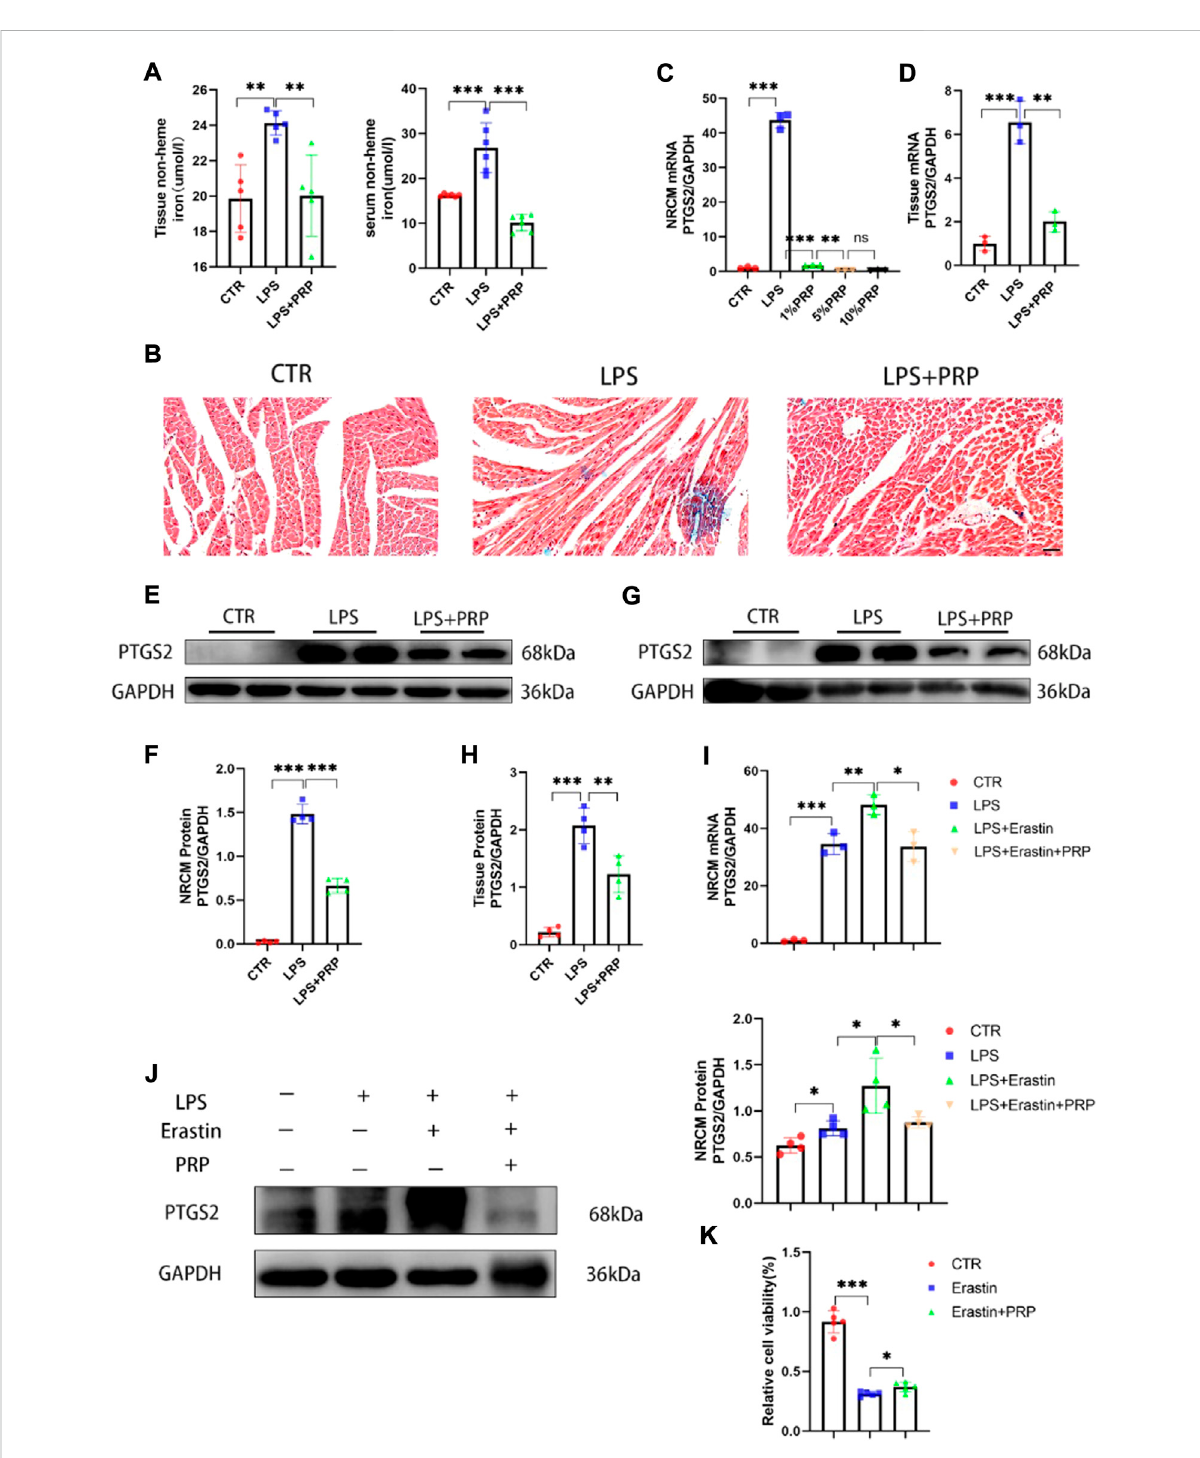
PRP inhibited ferroptosis induced by LPS. (A) Iron in tissues and serum were measured after LPS and PRP treatment ( n = 5, n = 6). (B) Prussian bluestainingforironinhearts(scalebar=50 µm). (C – D) ThemRNAlevels ofPTGS2after beingtreatedwithPRPinNRCMsandtissues( n =3). (E – H) TheproteinlevelsofPTGS2inNRCMsandtissues( n =4). (I – J) ThemRNAandproteinlevelsofPTGS2aftererastin(10 µM)andPRPtreatmentfor6 h ( n =4). (K) EffectoferastinandPRPoncellviabilityaftertreatedfor24 h( n =5).*indicates p < 0.05.**indicates p < 0.01.***indicates p <